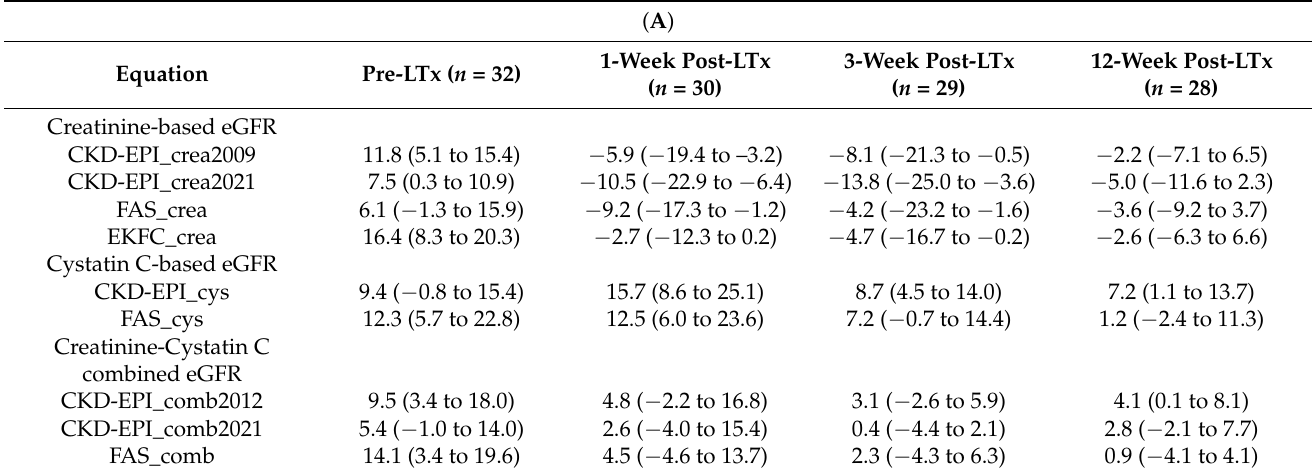
Table 3. ( A ) Median bias (95% CI) of eGFR equations compared with measured GFR at each timepoint, defined as mGFR–eGFR in normalized units (mL/min/1.73 m 2 ). ( B ) P30 accuracy (95% CI) of eGFR equations compared with measured GFR at each timepoint, defined as percent of cases within 30% of mGFR. ( C ) P15 accuracy (95% CI) of eGFR equations compared with measured GFR at each timepoint, defined as percent of cases within 15% of mGFR. ( D ) CKD class agreement (95% CI) between eGFR equations and measured GFR at each timepoint, defined as percent of cases within the same CKD category.